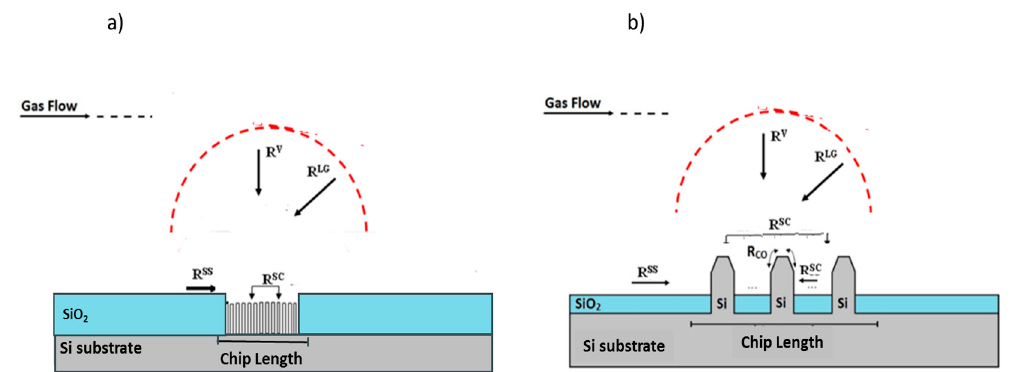
Figure 7. Schematic view of gas flow in different directions over a chip containing ( a ) planar transistors and ( b ) FinFETs. The dashed circles (sphere in 3D) representing a volume where the molecules around the transistor arrays (or chips) are